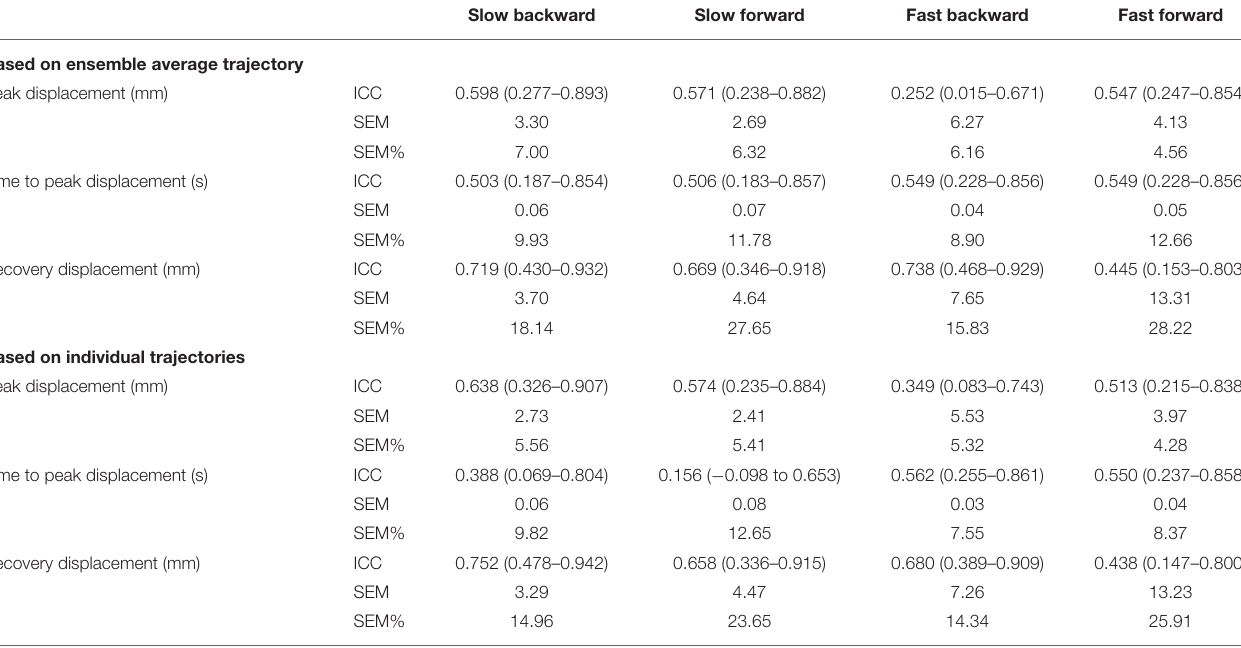
TABLE 1 | Test–retest reliability of the selected outcome measures describing perturbed postural balance